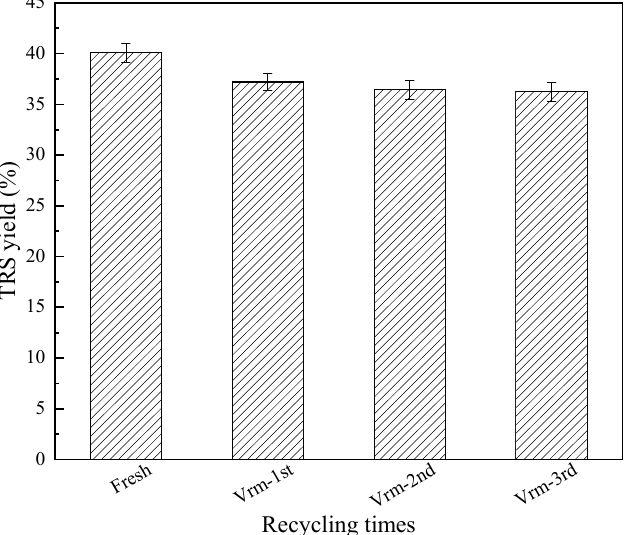
Figure 6. The reuse of acid-activated vermiculite in the cellulose hydrolysis.